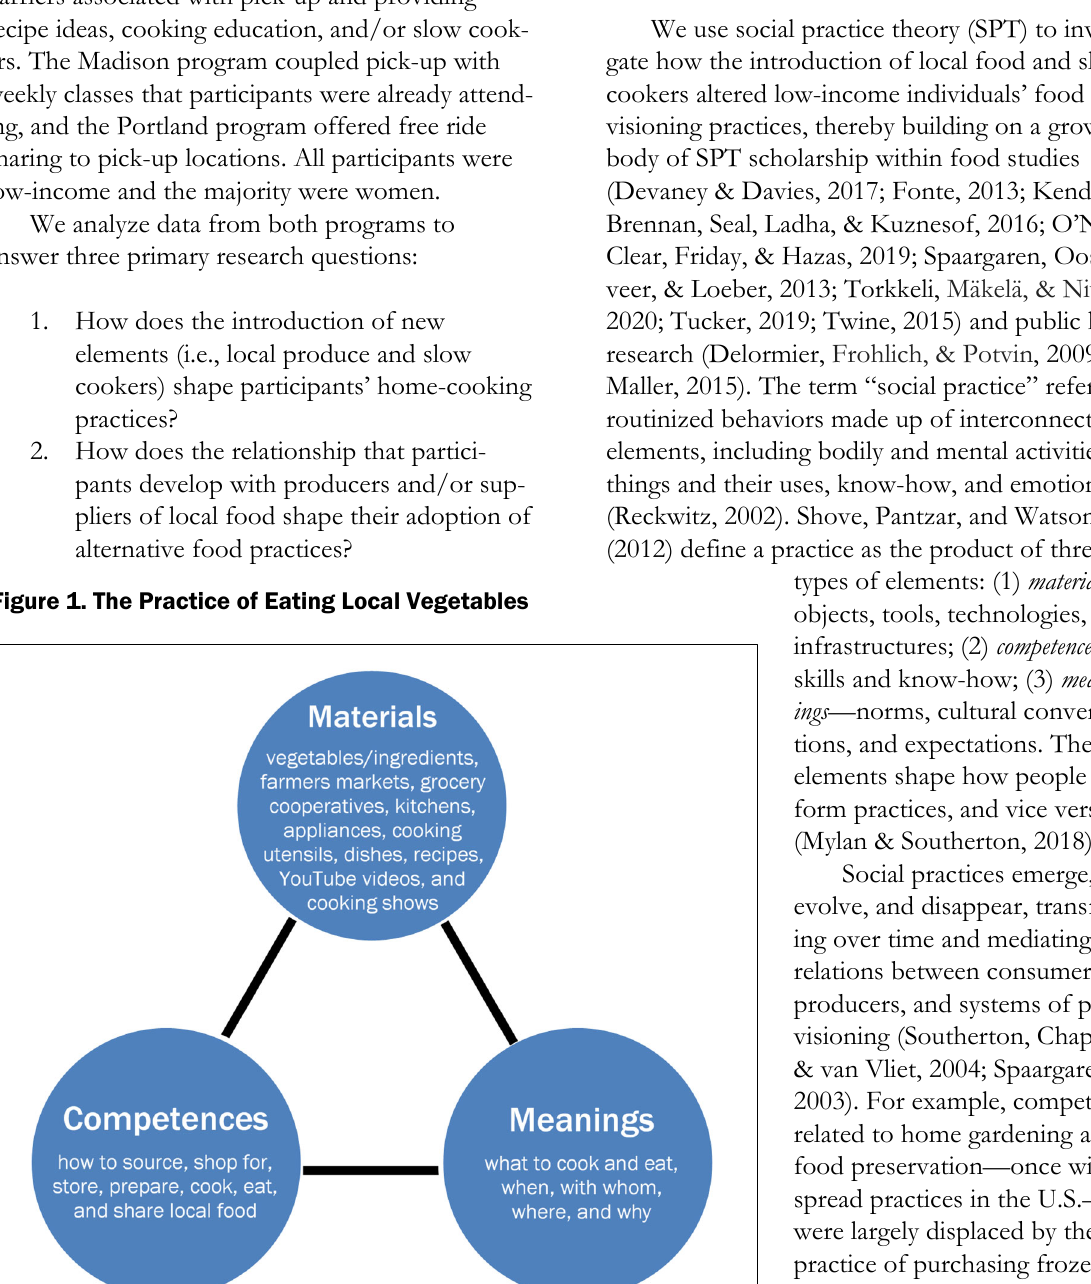
Source: Adapted from Maller,